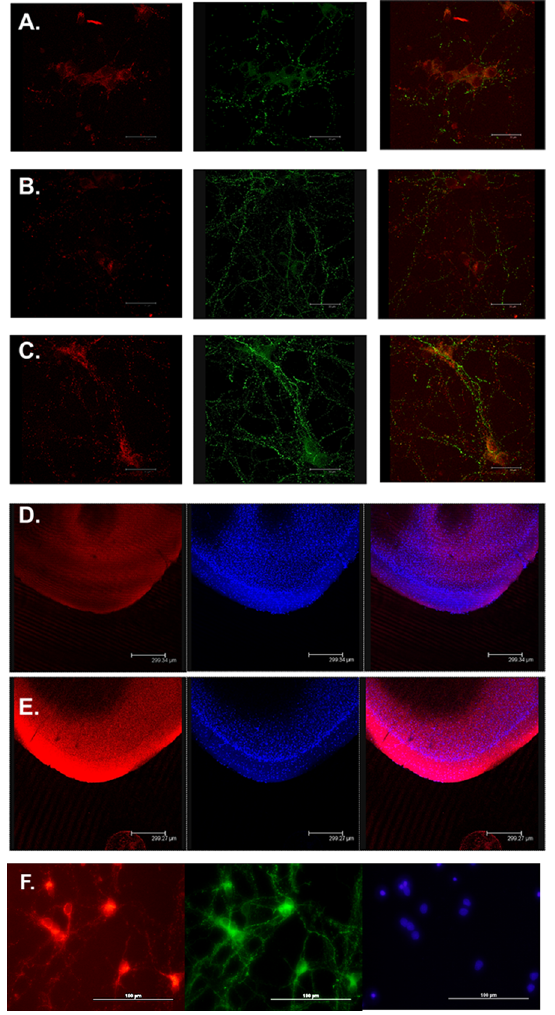
Figure 2. Mood stabilizer treatment resulted in increased mitochondrial transport to the synapse in cell culture as indicated by increased staining of neuronal processes and rat PFC tissue. From left to right: MitoTracker (red), SYN1 (green), and superimposed images (red and green). A. Saline control, B. Lithium (1 mM) treated cells, C. Paliperidone (10 m M) treated cells, D. Saline treated rat PFC tissue slice (left to right: MitoTracker red, DAPI nuclear stain and superimposed image), E. Lithium (22 mg/Kg) treated rat PFC tissue slice (left to right: MitoTracker red, DAPI and superimposed image). F. A close-up of localization of Mito Tracker red (red, left) and SYN1 (green) in paliperidone (0.1 m M) treated cells. Nuclei shown in blue (Secondary antibody: Alexafluor488 Mouse 1:1000, Mitotracker CFX-Ros 50 nM, Hoecsht nuclear stain 1:1000).